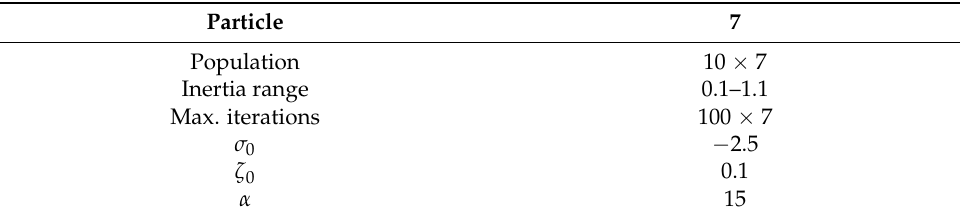
Table 3. PSO parameter setting.